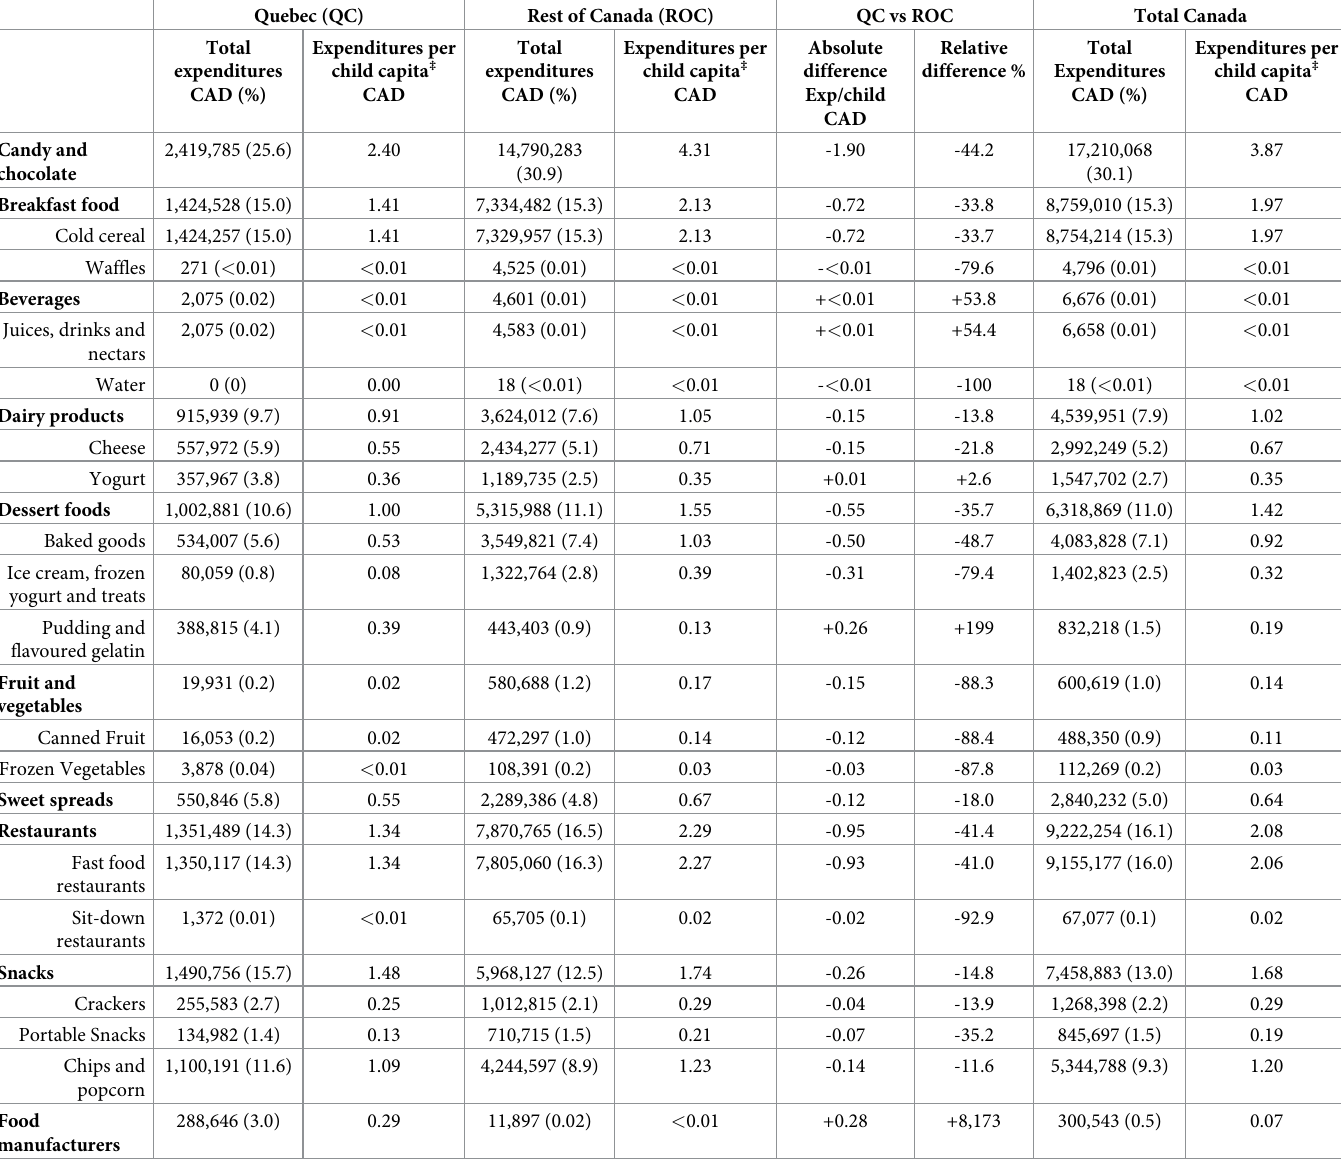
Table 4. Advertising expenditures on child-targeted products † across all media in 2019 by geographic region and food category. Quebec (QC) Rest of Canada (ROC) QC vs ROC Total